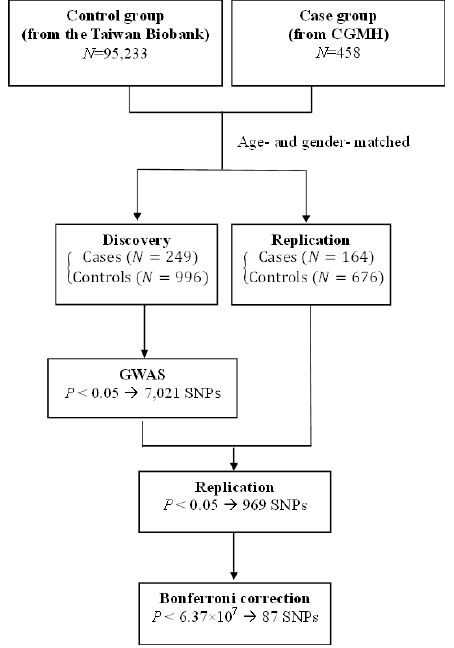
Figure 1. Flow chart of the study design. Table 1. Demographics of the study population.